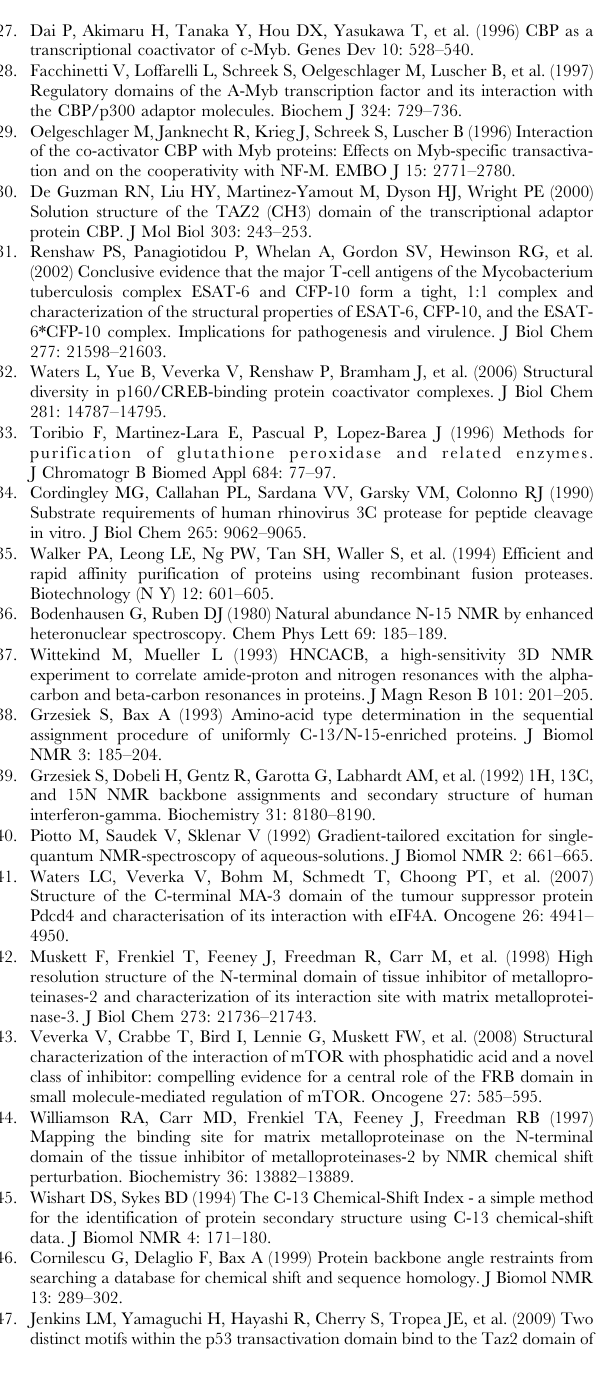
are rotated about the y axis by 90 u and 2 90 u compared to panel A.